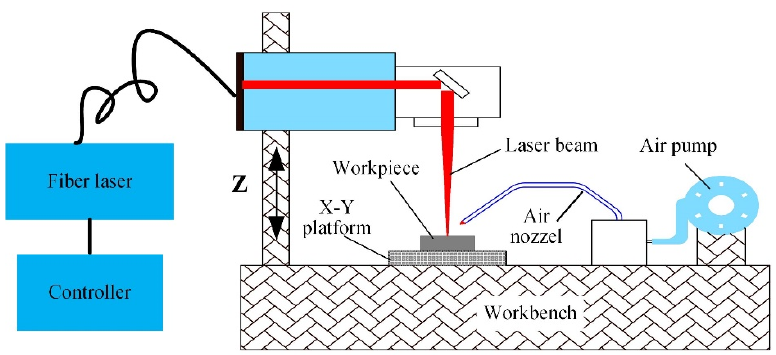
Figure 1. Schematic diagram of blowing-assisted laser processing.